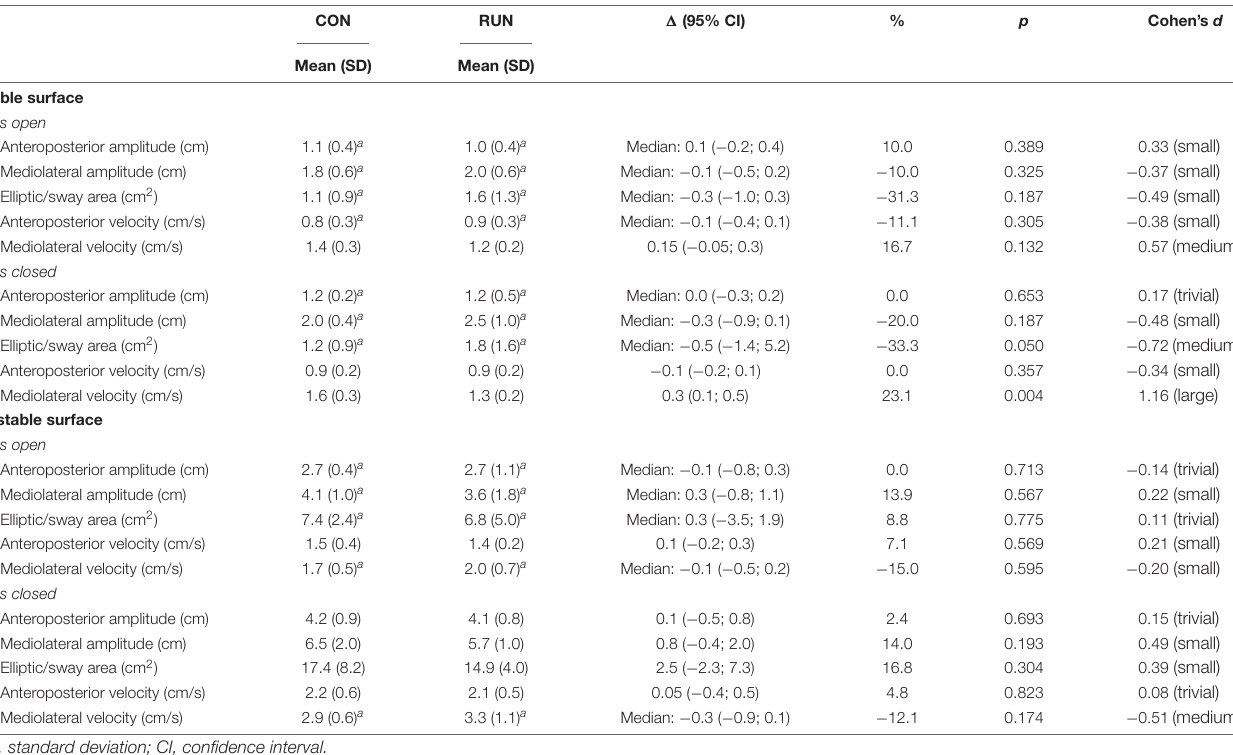
TABLE 2 | Profile of postural control variables of older recreationally active adults (CON, n = 15) and older master road runners (RUN, n = 15) groups.